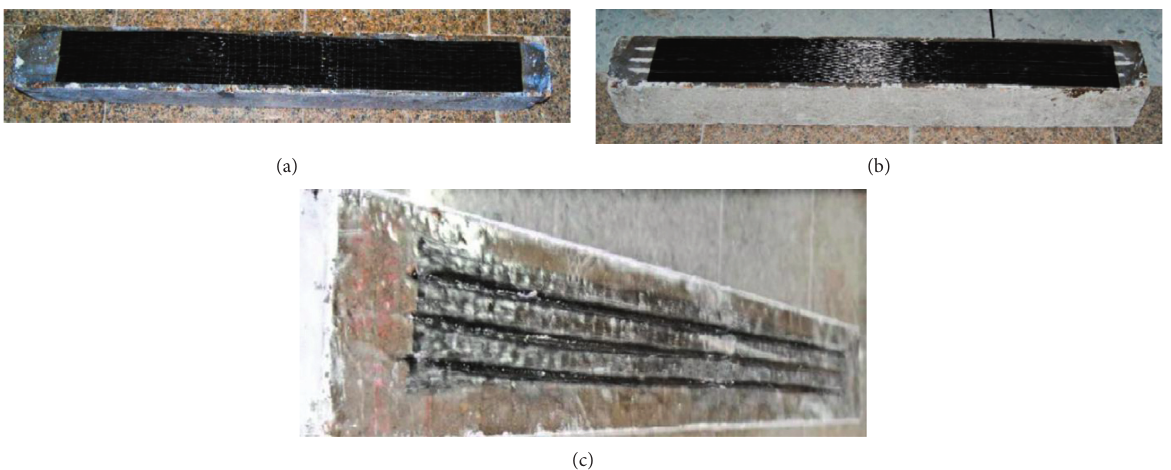
Figure 4: Specimens strengthened with (a) conventional surface preparation method, (b) externally bonded reinforcement on grooves technique, and (c) externally bonded reinforcement in grooves technique [56].